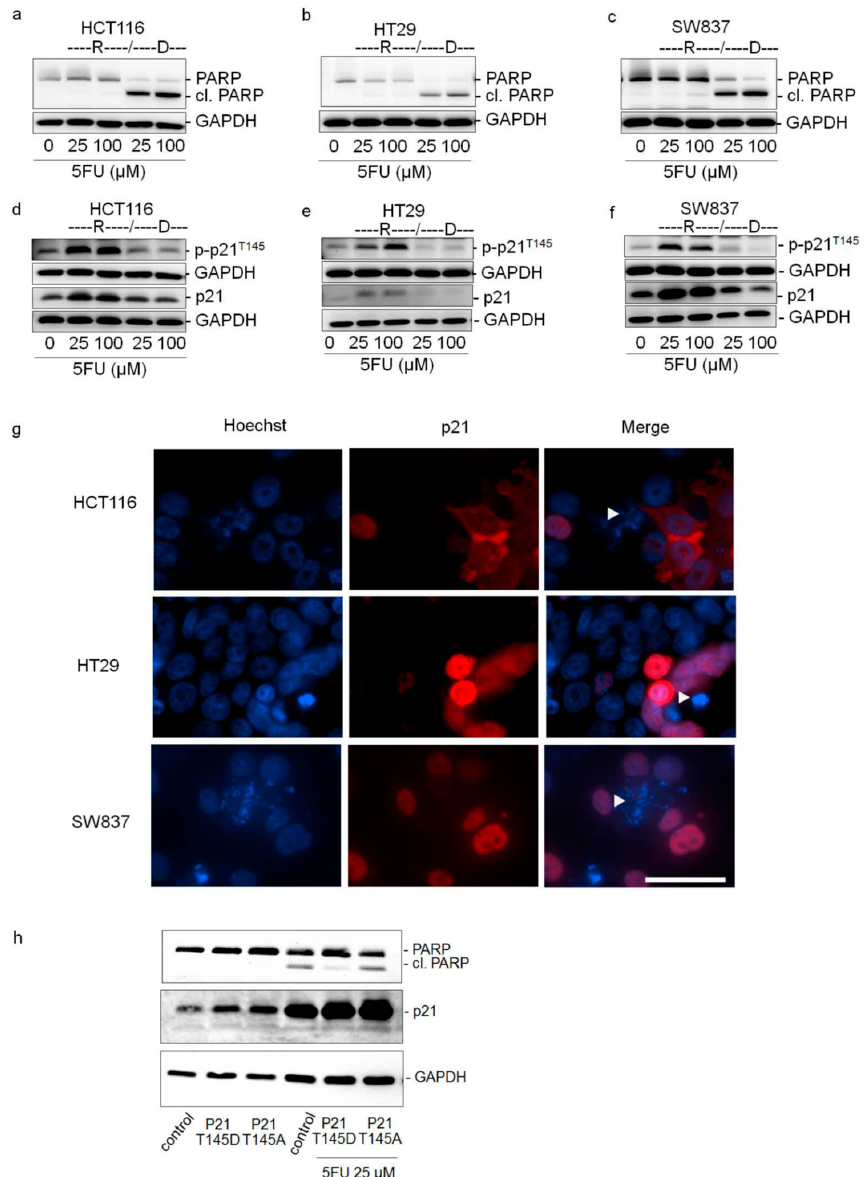
Figure 3. Cytoplasmic p21 mediates 5FU resistance in colorectal cancer cells. ( a – f ) The expression levels of PARP, cleaved PARP (cl. PARP), phosphorylated-p21 (p-p21 T145 ) and p21 in resistant cells (R) and dead cells (D) were determined by Western Blot analysis after 48 h of treatment with 5FU. For this, HCT116, HT29, and SW837 cells were treated with various concentrations of 5FU. After 48 h, resistant cells (R) and dead cells (D) were collected separately and protein lysates were prepared. The blots were re-probed with GAPDH to confirm equal loading of the samples. ( g ) Expression of p21 in viable and dead cells after 48 h of 5FU treatment. HCT116, HT29, and SW837 cells were treated with various concentrations of 5FU for 48 h and the expression levels of p21 were determined by immunofluorescence staining for p21 (red) and the cell nuclei (Hoechst 33342, blue). White arrow indicates apoptotic cells having condensed chromatin and/or fragmented nuclei. Scale bar: 50 µ m. ( h ) 5FU susceptibility of HCT116 cells transfected with hyperphosphorylated p21 T145D and unphosphorylatable p21 T145A . After 24 h of transfection, cells were treated with 5FU (25 µ M) for further 48 h. Untreated cells were used as controls. The expression levels of PARP, cleaved PARP (cl. PARP), and p21 were determined by Western Blot analysis. The blots were re-probed with GAPDH to confirm equal loading of the samples.